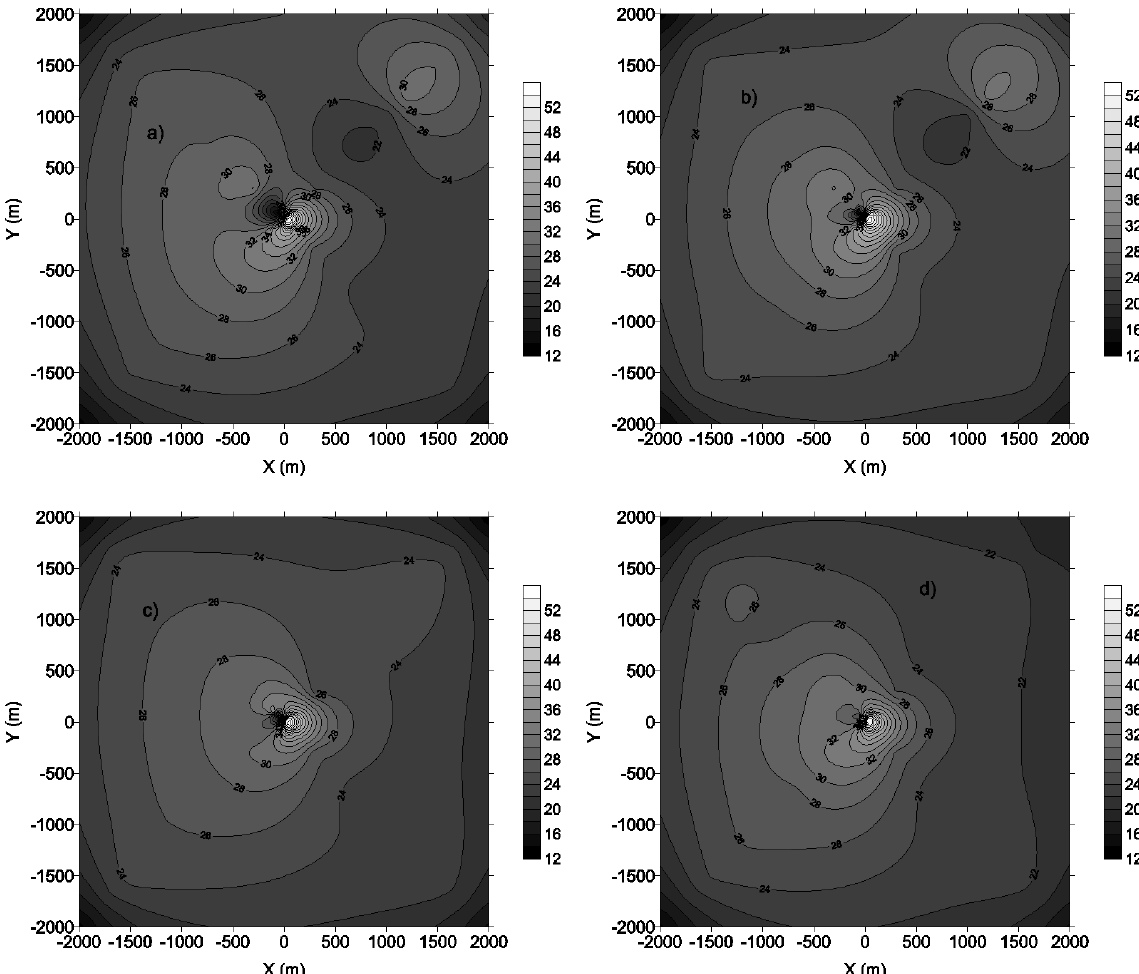
Figure 13. Concentration sensitivity to roughness length. This is the relative variation of the concentration patterns according to Equation (7) ( D ). The results are in %. ( a ) and ( b ) are rl the 3 h averaging time first and second highest concentration; ( c ) and ( d ) are 24 h averaging time first and second highest